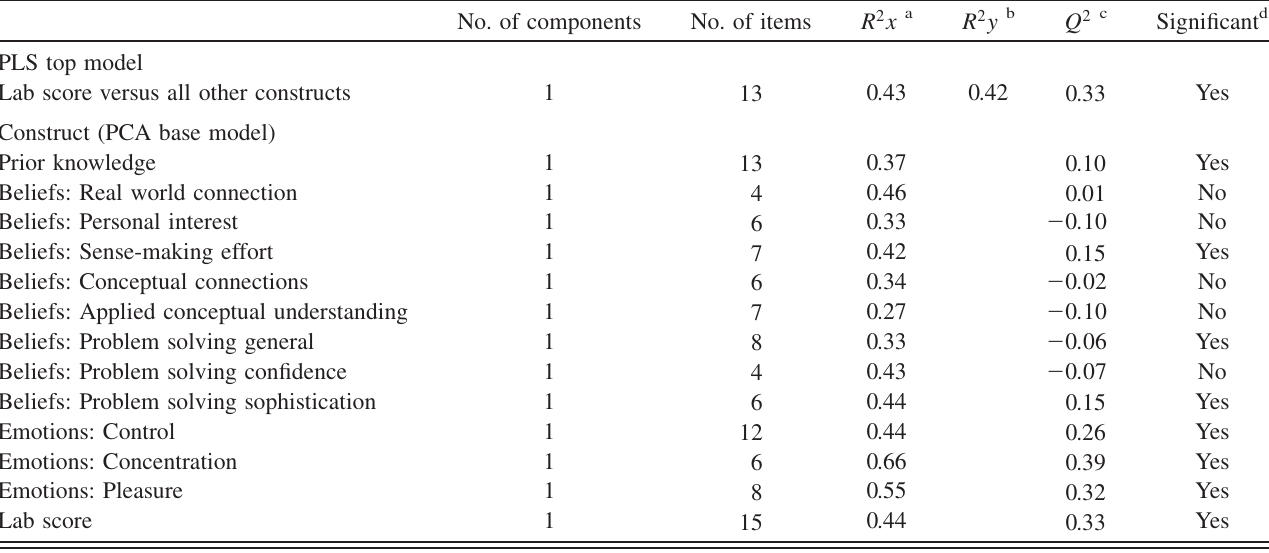
TABLE II. Statistics of PLS top model shown in Fig. 1 where outcome (lab score) is predicted by all other constructs, together with statistics of the PCA base models that represent each